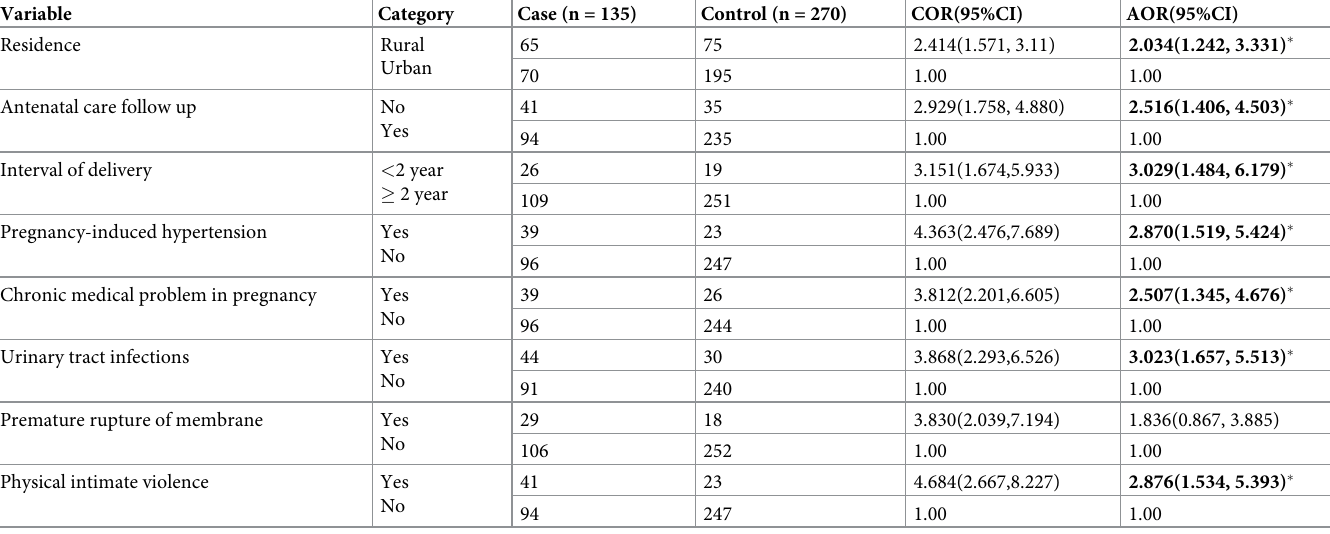
Table 5. Bivariate and multivariable logistic regression analysis of factors associated with preterm birth among mothers who gave birth at public hospitals in Sidama regional state, Southeast Ethiopia,